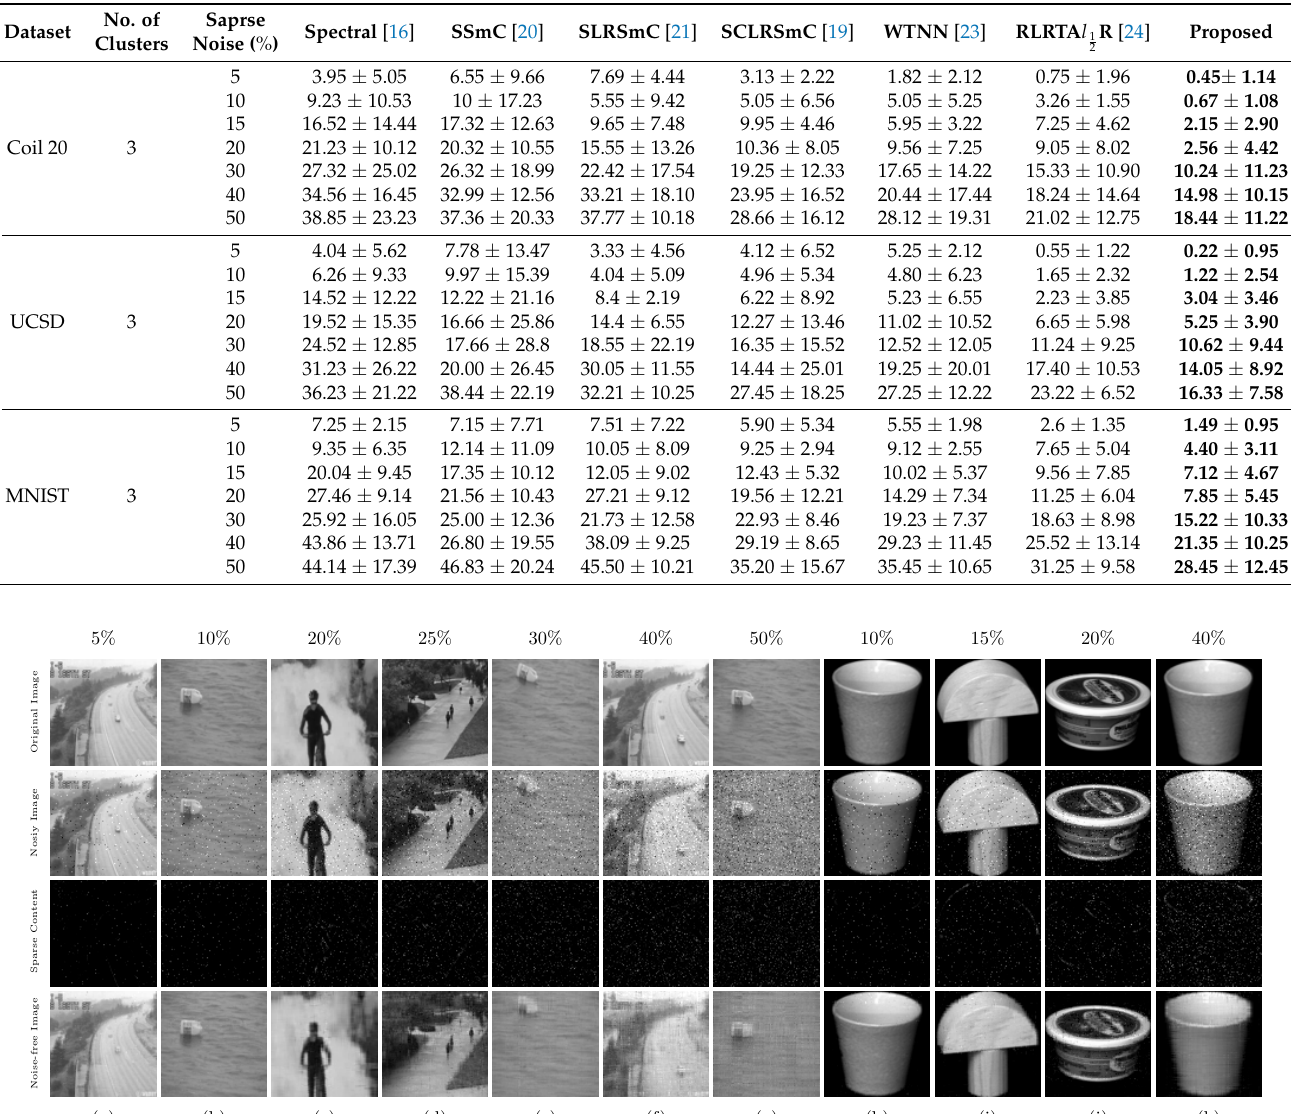
Figure 4. The proposed method’s efficiency is also checked using the MNIST dataset [19]. the MNIST dataset comprises images of handwritten digits from 0 to 9 with a resolution of 28 28, where the number of images that belong to class is set as 30. The MCR metrics × obtained for the proposed as well as the compared methods are summarized in last section of Table 1. The proposed method produces better clustering results than the state-of-the-art methods. Table 1. Table represents compared results of MCR ( m σ ) % for Coil20, UCSD and MNIST datasets. Best values are ± highlighted in bold letters.